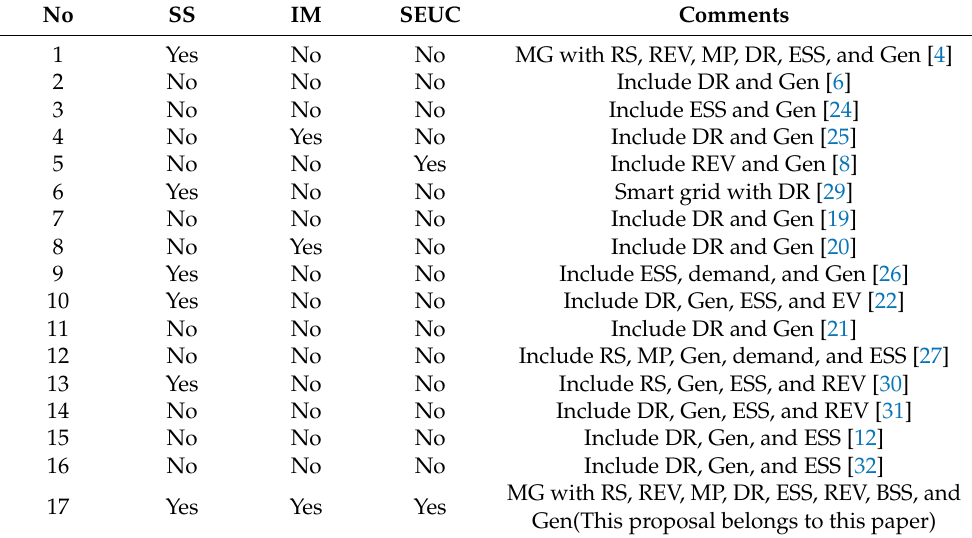
Table 1. Review of electrical